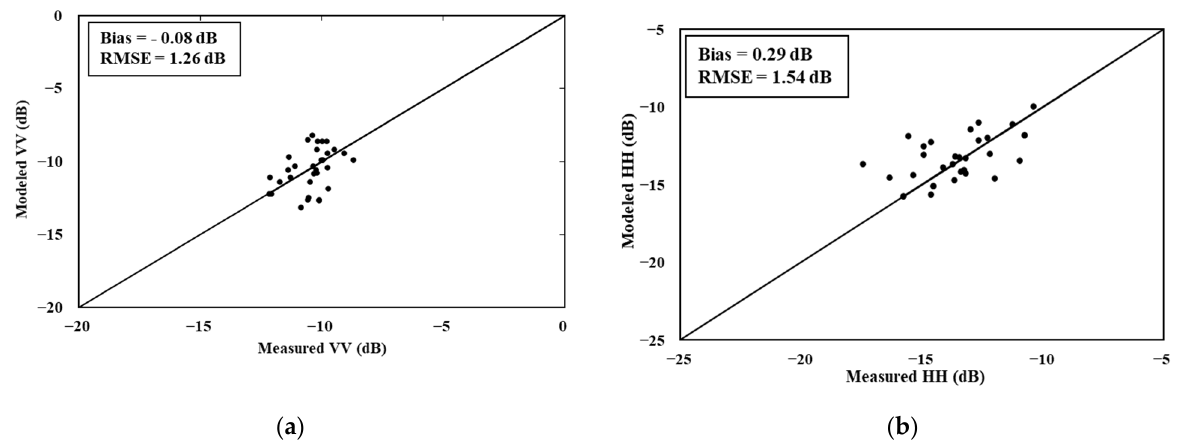
Figure 9. Comparison of the radar data and simulated backscattering coefficients in the pepper fields: ( a ) C ‐ VV configuration and ( b ) L ‐ HH